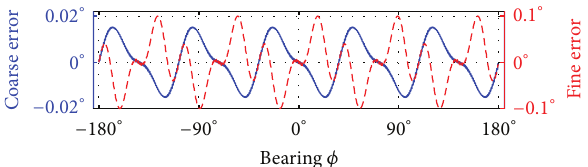
Figure7:Bearingmeasurementerrorscomputedfromthephasesof 𝑝 𝑝 1Σ and 9Σ for coarse (solid curve) and fine (dashed curve) bearing information,